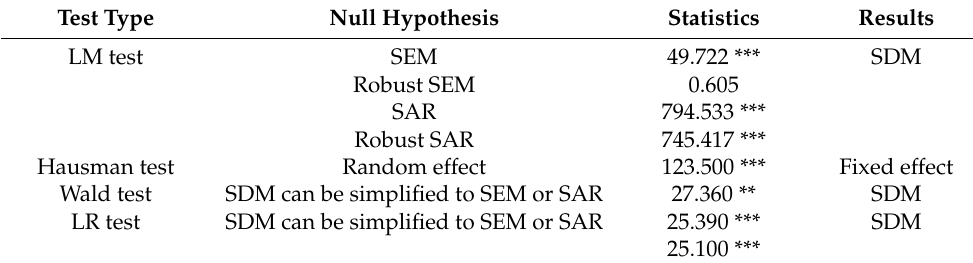
Table A4. Test results related to model